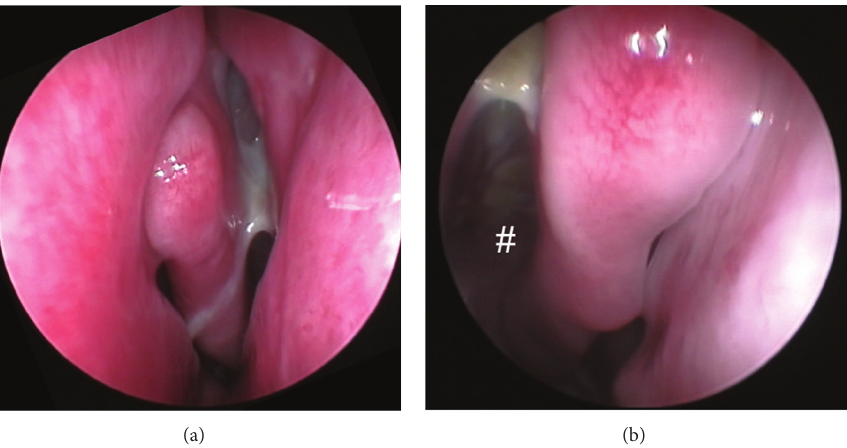
Figure 3: (a) and (b) Anterior rhinoscopy from patient number 3 six years after sinonasal surgery. (a) Abundant mucoid secretions draining from middle meatus left side; (b) # view into postoperative polyp-free ethmoid sinus, mucoid secretion on the roof of the